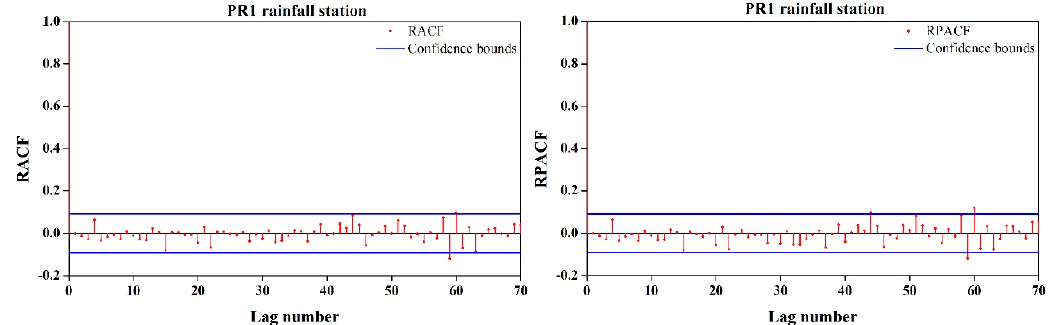
Figure 3. The ACF and PACF of residuals at the PR1 station in the Pozi River basin.